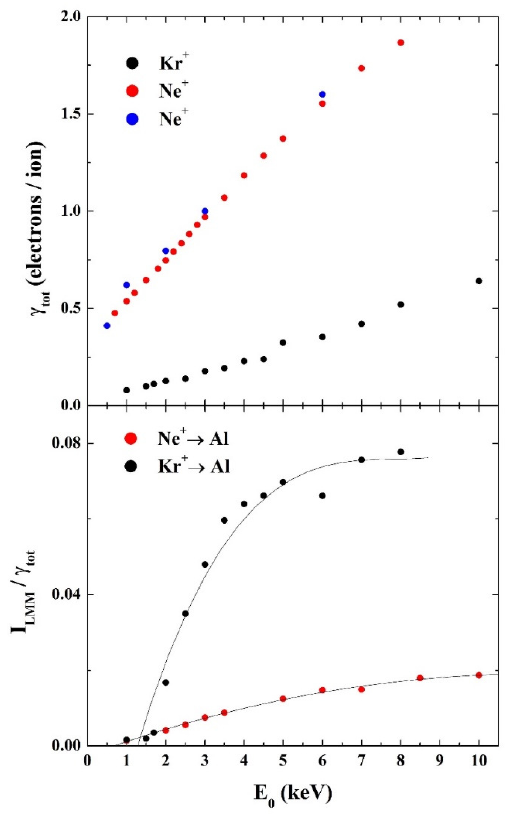
Figure 11. ( Top ): Electron emission yields γ tot for Kr + [17] and Ne + impact on Al (blue circles are from this work, red circles are from [32]). ( Bottom ): The ratio R = I HE /I for Kr + [17] and Ne + impact on Al. The lines through data points are to guide the eyes.